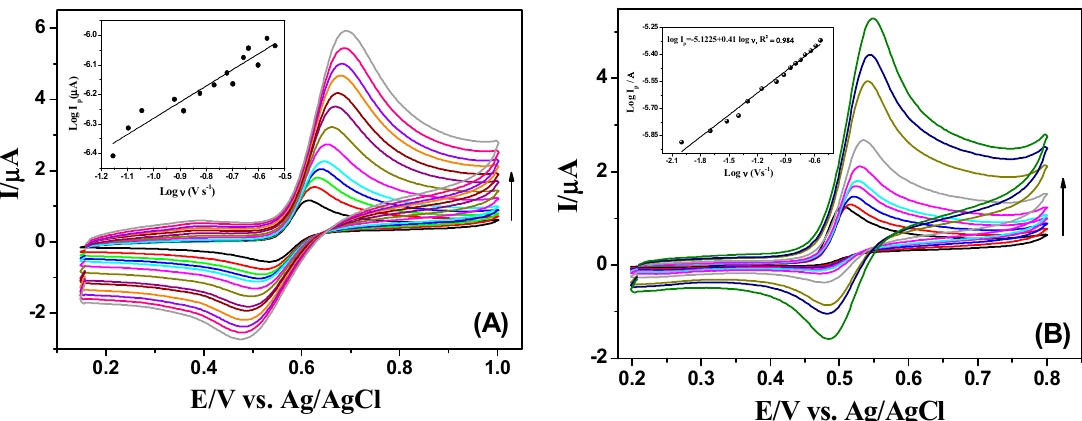
Figure 4. Cyclic voltammetry of the rGO/GCE in 0.04 M B–R (pH 2.1) containing ( A ) 0.1 mM GA and ( B ) 0.1 mM PA at different scan rates (10, 20, 30, 40, 50, 80, 90, 120, 150, 170, 190, 200, 230, 270 and 290 mV·s − 1 ).